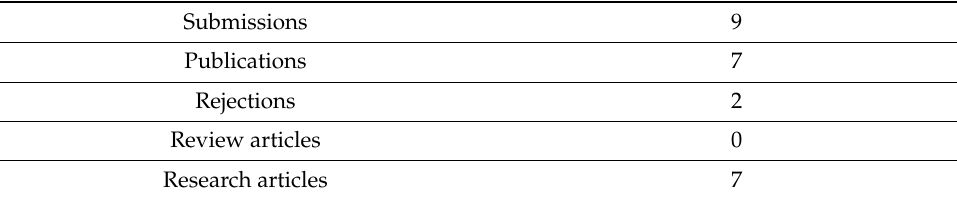
Table 1. Statistics for the call.